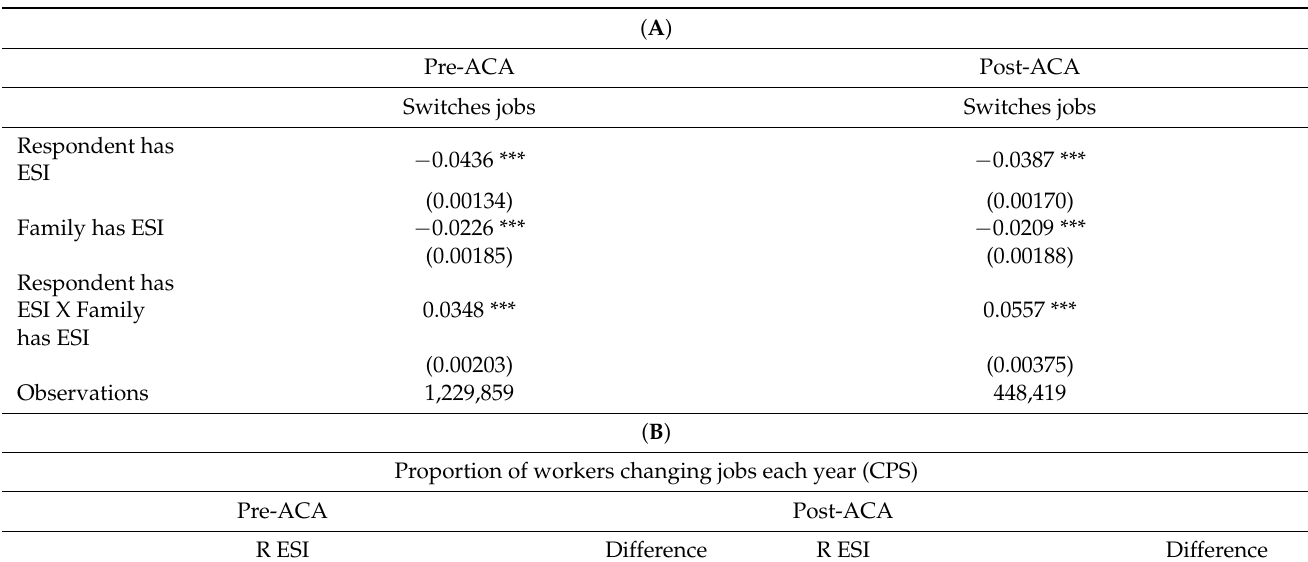
Table 4. ( A ) Difference-in-Differences Estimates of Partner ESI on Job Mobility. CPS Analyses. ( B ) DD using Partner’s Insurance as Cost Factor.